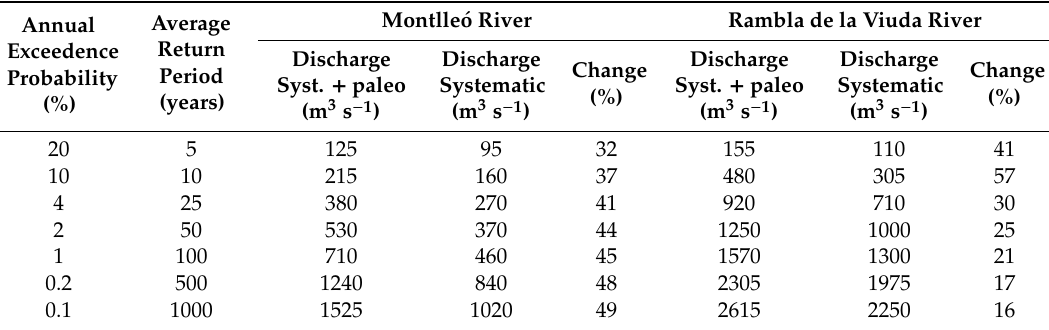
Table 3. Flood quantiles for di ff erent exceedance annual probabilities in Montlle ó River (657 km 2 ) and Rambla de la Viuda (1500 km 2 ) fitted to, firstly, the annual maximum discharge of the systematic record only, and secondly to the combined systematic and palaeoflood discharges. The di ff erence in % represents changes on flood probability introduced by climate variability related to “flood-rich” periods. Rambla de la Viuda frequency analysis for a two-component extreme value (TCEV) [20].